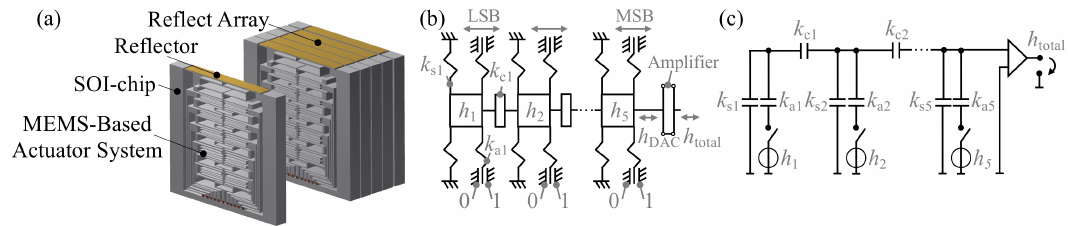
Figure 3. ( a ) Illustration of the reflective array, ( b ) structure of the 5-bit DAC, ( c ) analogous electronic network